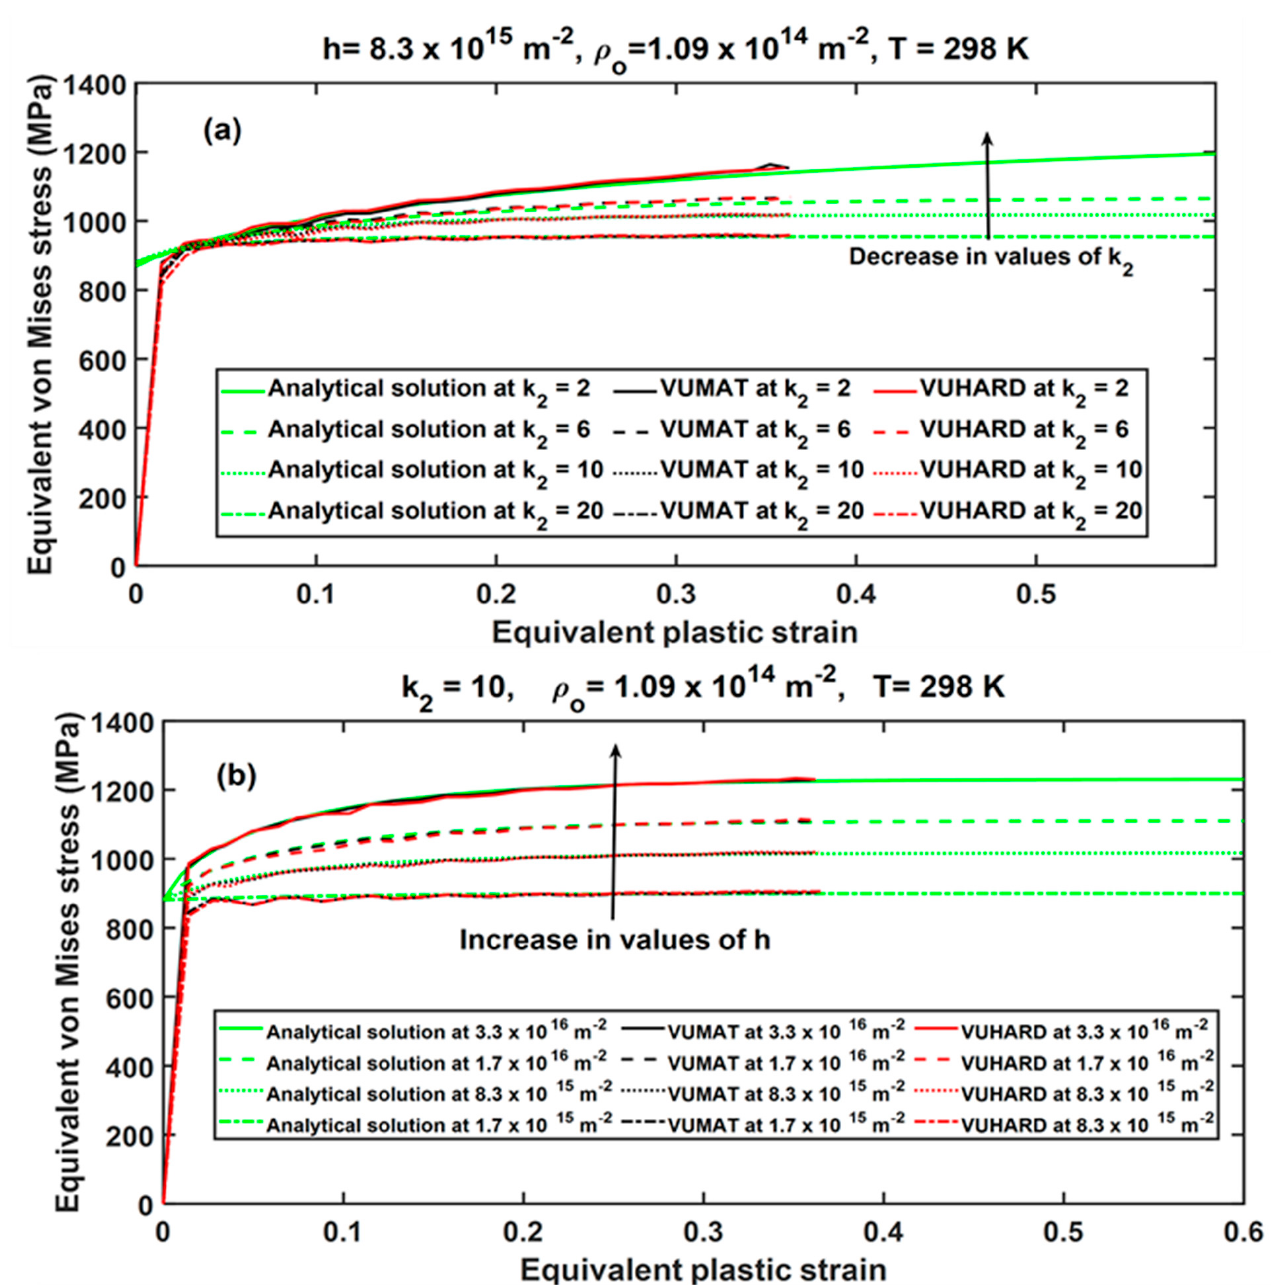
Figure 7. The effects of model parameters ( a ) k 2 and ( b ) h on the numerical solutions derived from VUMAT and VUHARD subroutines and compared with the analytical solution at the same conditions of 350 s − 1 and 298